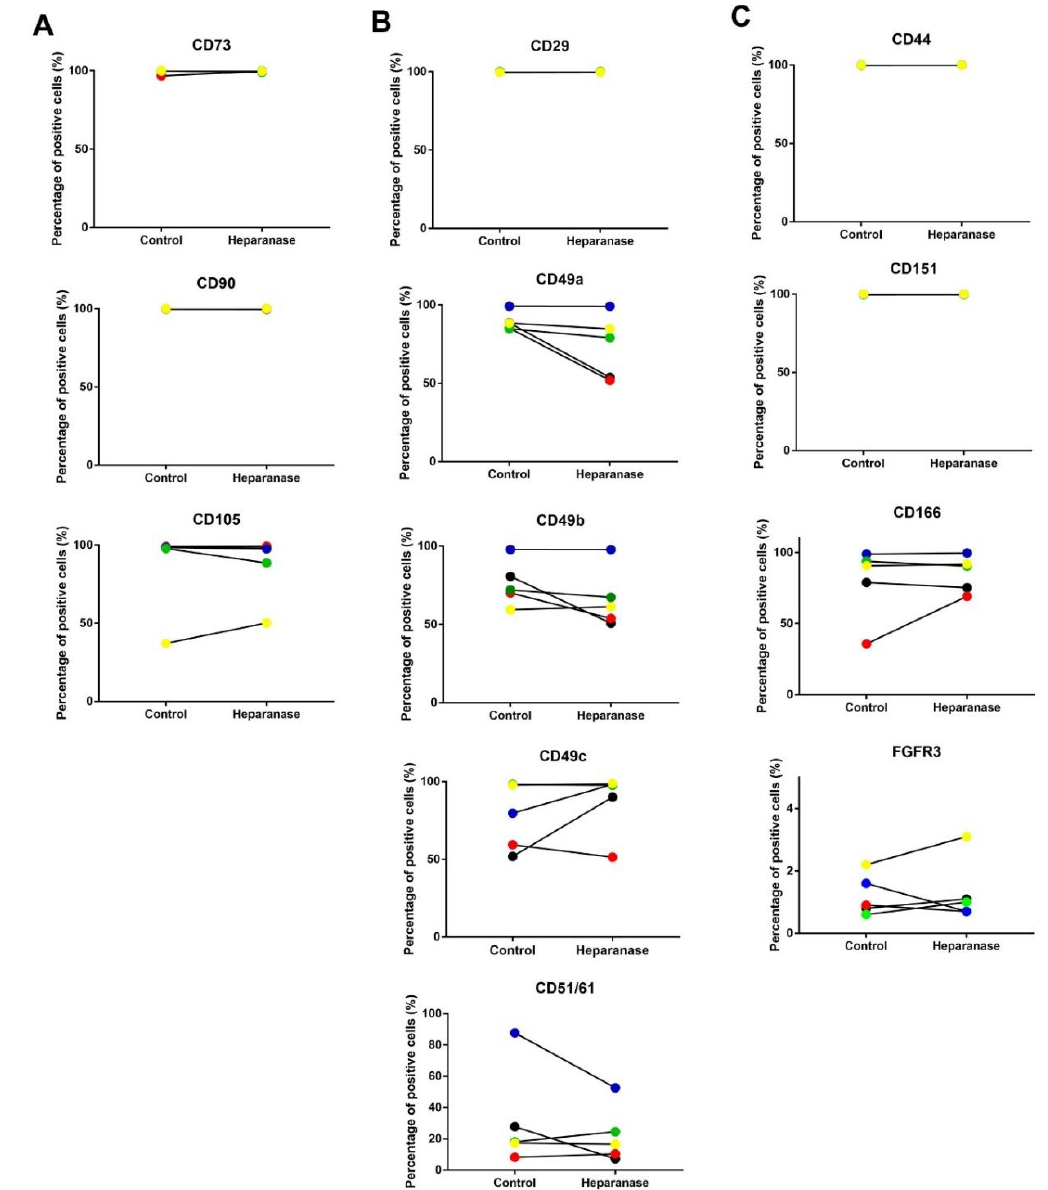
Figure 6. Flow cytometry analysis of the effects of heparanase treatment on surface markers of chondrocytes ( n = 5). Results are shown as the percentage of positive cells for a particular marker on heparanase-treated chondrocytes and the matching control. Fluorochrome-conjugated antibodies were used to detect ( A ) stem cells markers, ( B ) integrins and ( C ) chondrogenic markers. No significant differences were observed. Matched samples are represented by the same colour dot; donor 16 (black), donor 17 (red), donor 18 (blue), donor 19 (green), and donor 20 (yellow). Although the relative fold change in chondrogenic gene expression was not statistically significant between the heparinase-treated and untreated chondrocytes, there was a general decrease in SOX9 expression (median= − 1.17), and increased expressions for